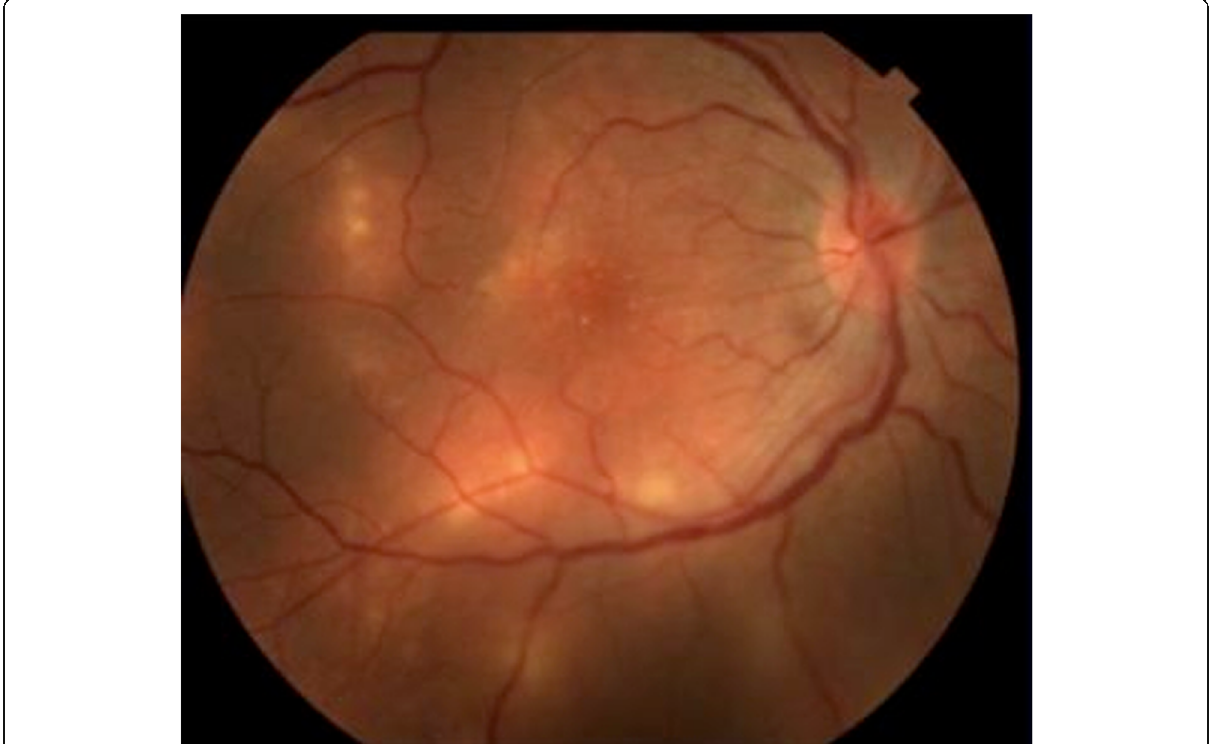
Fig. 1 Multifocal gray-white lesions in the right eye of a presumed DUSN